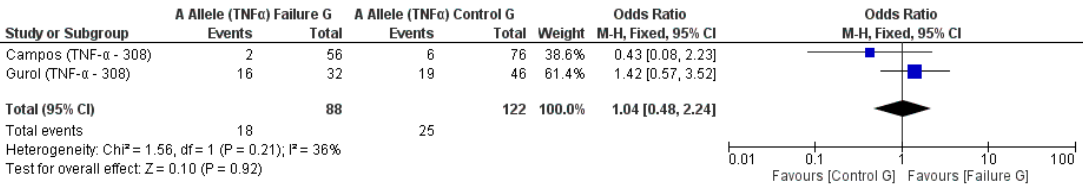
Figure 6. Odds ratio and forest plot for the prevalence of TNF- α -A308 allele in the failure group (at least one implant failure) vs. control group (without implant failure). The OR of the combined data crossed the line of no difference.